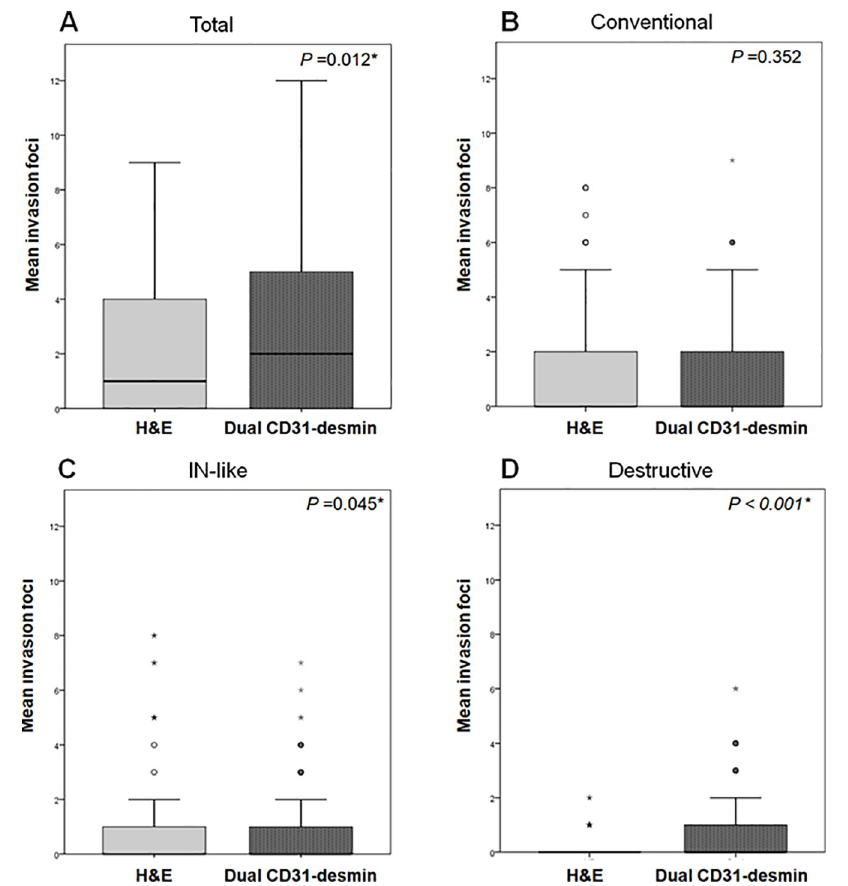
Fig 7. Comparisons of mean number of foci of VI of pancreatobiliary tract cancers on the validation set. (A) Total foci of VI regardless of invasion pattern and invasive foci exhibiting the (B) conventional, (C) IN-like, and (D) destructive patterns as assessed by H&E staining and dual CD31–desmin immunolabeling among the validation set. (A) Dual CD31–desmin immunolabeling detected more invasion foci of VI regardless of the invasion pattern than H&E staining ( P = 0.012). (B) No significant difference was observed in the detection of the conventional pattern of VI between H&E staining and dual CD31–desmin immunolabeling. (C) Dual CD31–desmin immunolabeling detected more invasion foci exhibiting the IN-like pattern of VI than H&E staining ( P = 0.0045). (D) Similarly, dual CD31– desmin immunolabeling detected more invasion foci exhibiting the destructive pattern than H&E staining ( P < 0.001).